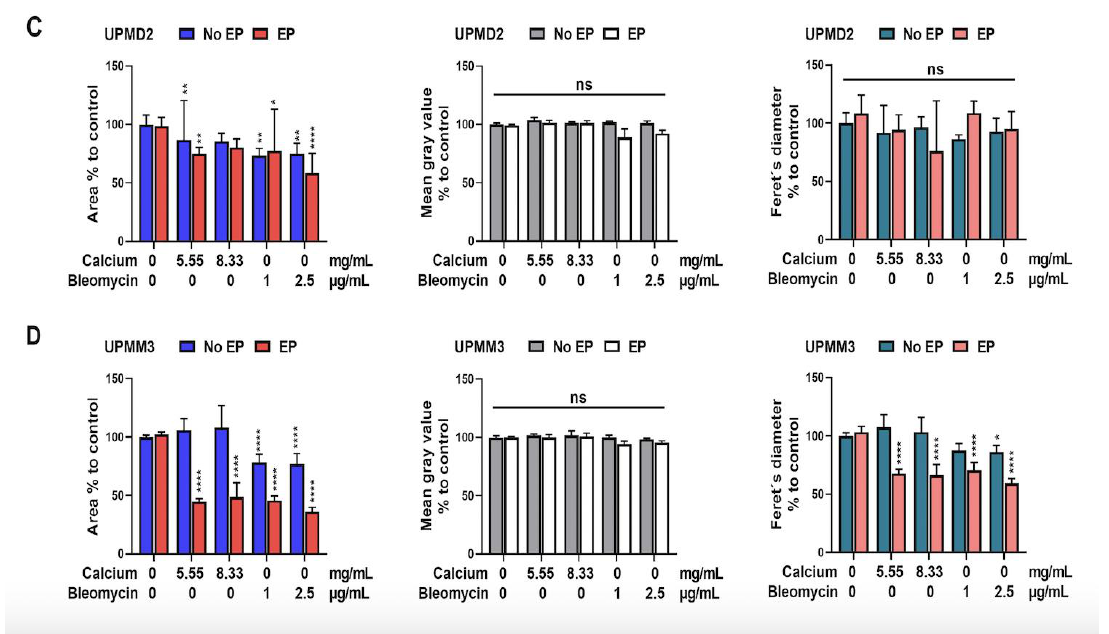
Figure 5. Cross-sectional area, mean gray value, and Feret’s diameter of UM and UPM spheroids on day 7 following EP in combination with calcium chloride or bleomycin. ( A ) UM92.1, ( B ) Mel270, ( C ) UPMD2, and ( D ) UPMM3 spheroids were incubated with different concentrations of calcium chloride (0.55, 1.11, 2.78, 5.55, or 8.33 mg/mL) or bleomycin (1 μg/mL or 2.5 μg/mL) and electroporated (1000 V/cm pulse strength, 100 µs pulse duration and 5 Hz repetition frequency; red (EP). Untreated cells, calcium chloride alone, bleomycin alone (no EP group), or EP alone constitute the control groups. To assess spheroid density, mass, expansion/shrinkage, the area (left column), the optic density (mean gray value; middle column), and the mean Feret´s diameter area (right column) of the detected spheroid or spheroid compartments were calculated ( n = 4 – 5 each condition). Statistical analysis was performed using a two- way ANOVA and Tukey’s multiple comparisons test. Significance levels are indicated with * p < 0.05, ** p < 0.01, *** p < 0.001, **** p < 0.0001.